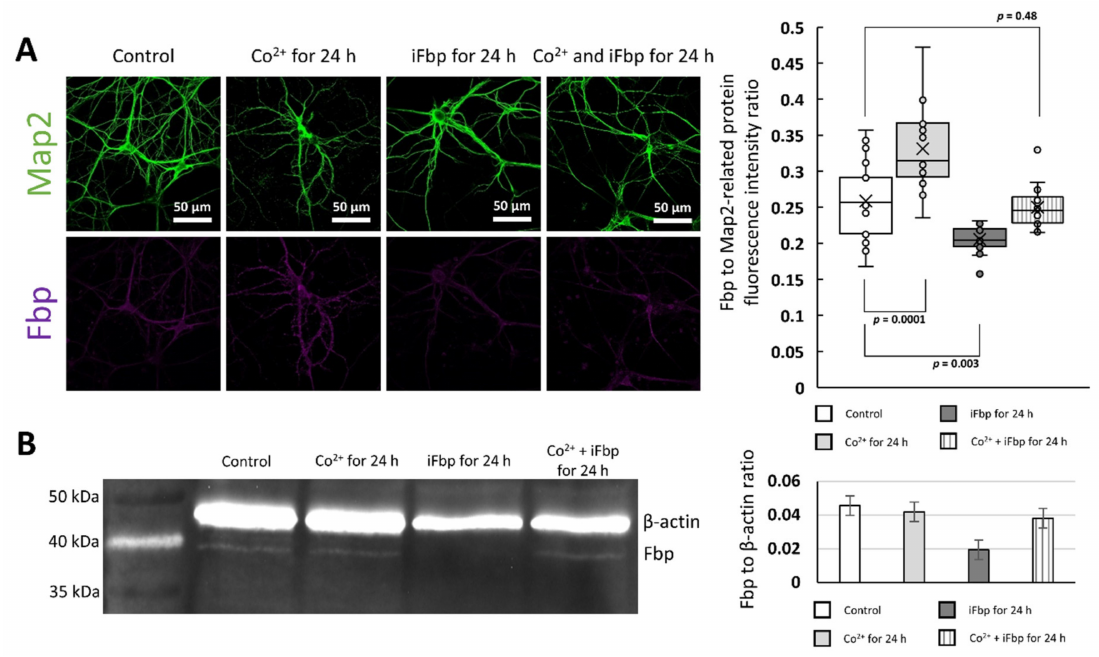
Figure 3. Quantification of Fbp2 protein in Co 2+ -treated neurons. ( A ) Fbp-related fluorescent signal in neurons incubated with Co 2+ is significantly higher than in control cells, whereas the fluorescence is lower in iFbp-treated cells. The decrease in Fbp fluorescence is not observed in neurons treated simultaneously with iFbp and Co 2+ . ( B ) Western blot analysis demonstrates that Fbp2 protein amount does not differ significantly among control neurons, neurons incubated with Co 2+ , and with Co 2+ /iFbp mixture. Tetramerization of Fbp2 with iFbp reduces the protein-associated signal in comparison to control